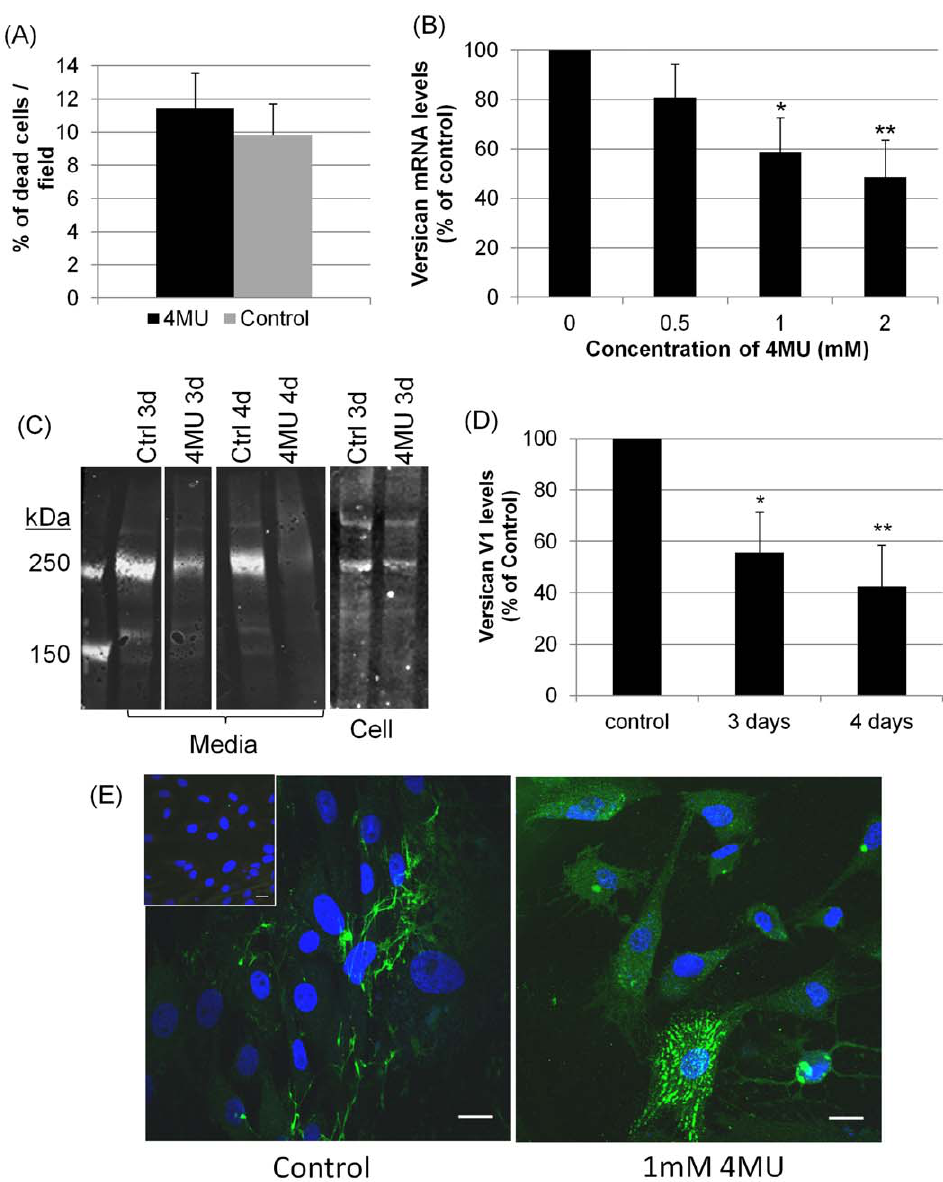
mRNA levels were assessed by qRT-PCR in TM cells treated with 0, 0.5, 1 and 2 mM 4MU for 24 hours. mRNA levels were normalized to 18S RNA levels and presented as a percentage of the vehicle control. Error bars are the s.e.m.; n=3; * p=0.04 and ** p=0.026 by one-way ANOVA. (C) Western immunoblots of versican in conditioned media and RIPA lysates from TM cells treated with vehicle-control (ctrl) or 1 mM 4MU for 3 and 4 days. All media lanes are from different lanes of the same immunoblot. Cell lanes are from adjacent lanes of the same immunoblot. (D) Densitometry of the V1 isoform (265 kDa) in the media showed a significant reduction with 4MU treatment at 3 and 4 days. Versican levels were normalized to total protein loaded and are presented as a percentage of the control. Error bars are the s.e.m.; n=4 for 3 days, n=3 for 4 days. * p=0.031 and ** p=0.024 by